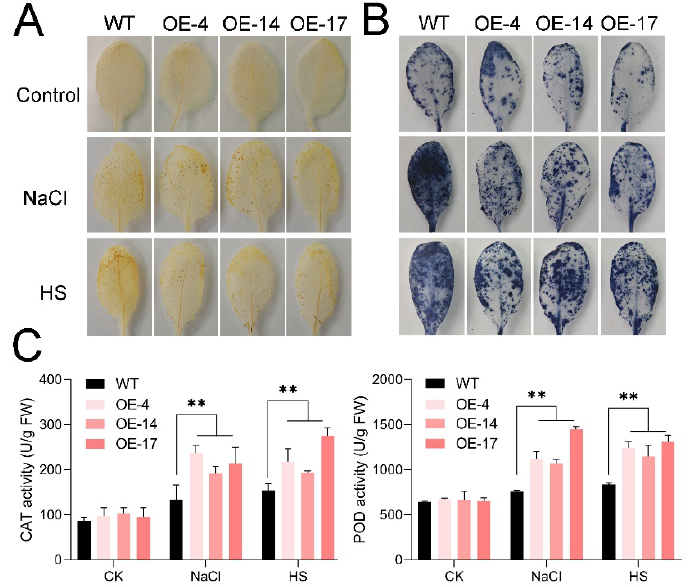
Figure 5. Oxidative stress analysis of the transgenic Arabidopsis with HuTZF3 overexpression. ( A , B ) Detection of H 2 O 2 and O 2 − by DAB ( A ) and NBT ( B ) staining. ( C ) The activity of CAT and POD under salt and heat treatments. Four-week-old Arabidopsis WT and overexpression HuTZF3 plants were exposed to 300 mM NaCl for 4 h, and 42 ◦ C for 4 h. Three replicates of the experiments were performed. Values are means ± SD ( n = 3). Asterisks show the values that are significant compared to WT. ** p < 0.01 according to the Student’s t - test.